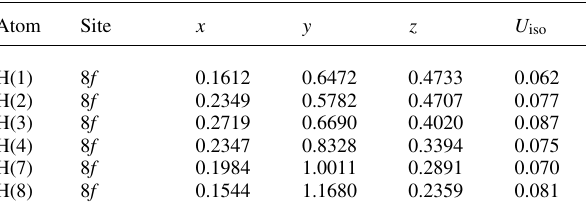
Table 2. Atomic coordinates and displacement parameters (in Å 2 )